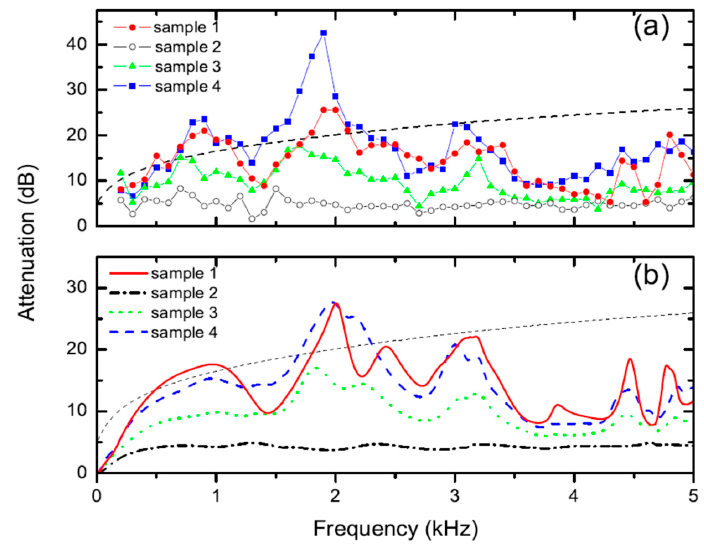
Figure 2. ( a ) Attenuation spectra measured for several SC barrier samples implemented on the campus at the Universitat Polit è cnica de Val è ncia; ( b ) corresponding calculated spectra simulated according to procedure described in